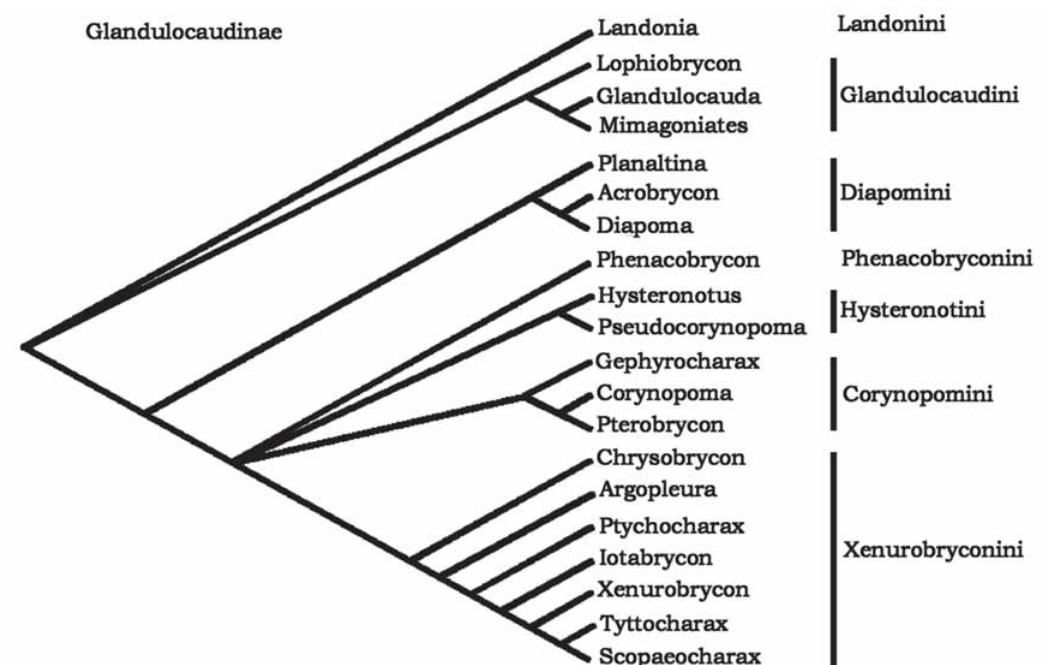
Fig. 8 . Modified Weitzman & Menezes (1998) consensus tree, obtained running those author’s matrix for 19 glandulocaudine genera and 51 characters with data for Lophiobrycon weitzmani